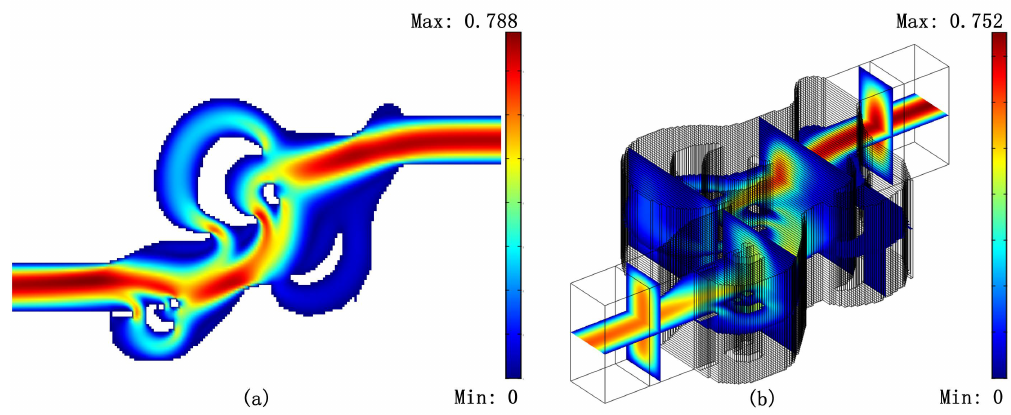
Figure 6. Reverse flow velocity field of the 2D model ( a ) and its 3D counterpart ( b ) for the optimized Tesla valve with the value of C max = 0.408 in Figure 4.